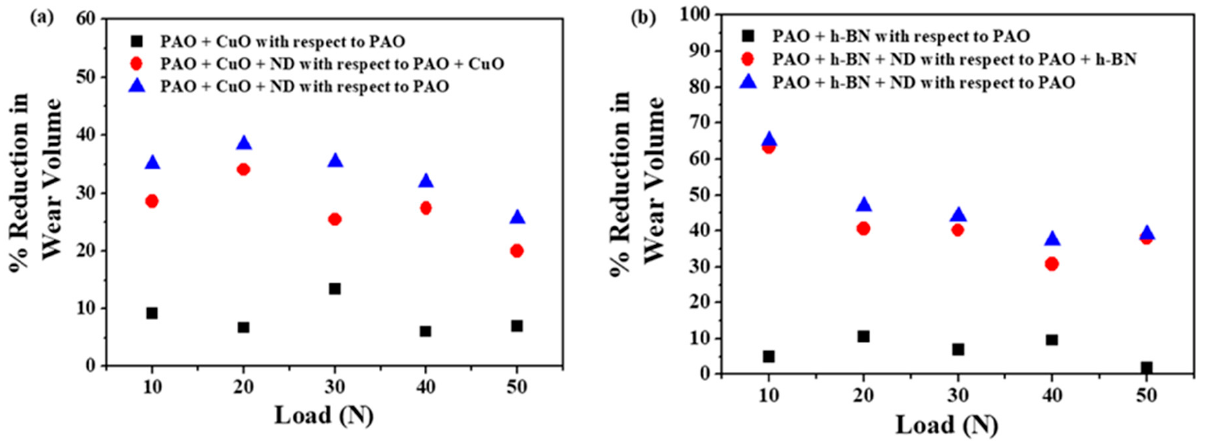
Figure 16. Percentage reduction in the average values of wear volume of Al alloy discs under: ( a ) PAO + CuO primary additive/+ ND secondary additive nanolubricants and ( b ) PAO + h-BN primary additive/+ ND secondary additive nanolubricants.